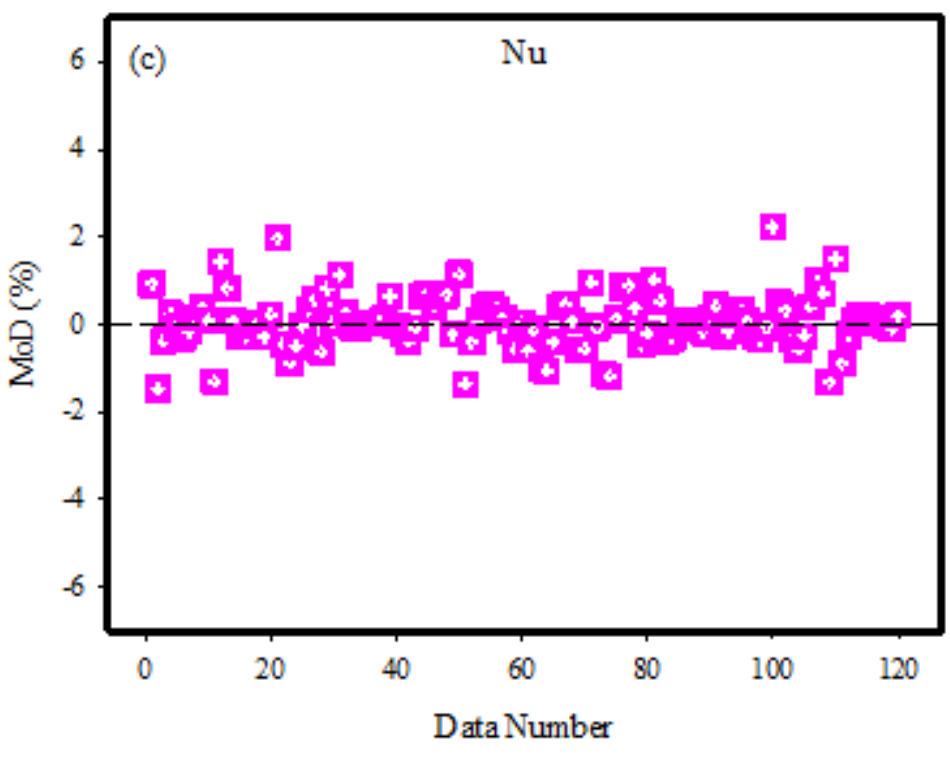
Figure 5. ( a ) The MoD values for ANN model-I. ( b ) The MoD values for ANN model-II. ( c ) The MoD values for ANN model-III.